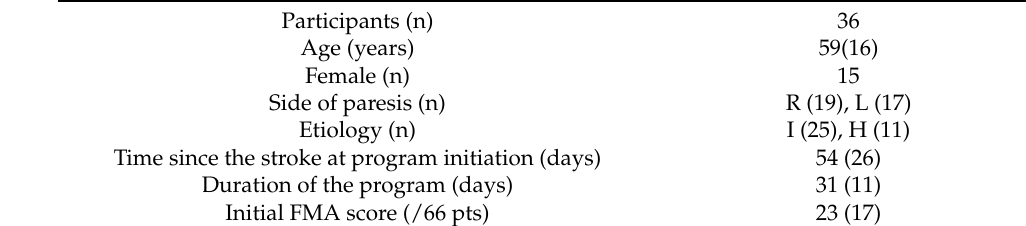
Figure 1. Flow diagram of the criteria for patient inclusion. Table 1. Baseline characteristics of